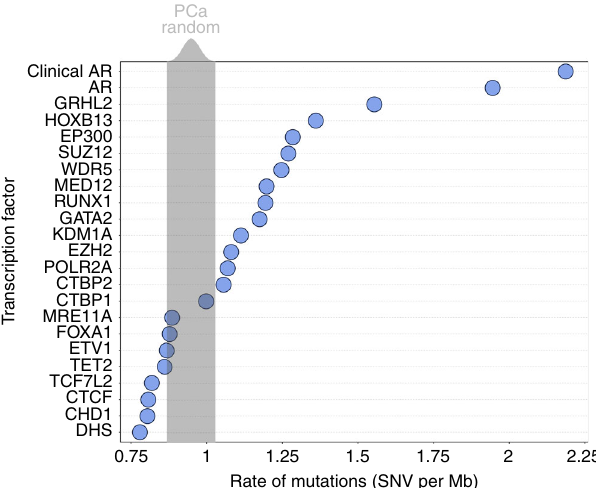
Fig. 1 ARBS sites are the most heavily mutated TF-binding sites. The rate of mutations (SNV per Mb) at individual TF-binding sites ( n = 22) and DHS regions were compared with randomized chromosomal regions (1000 iterations, gray). All TF-binding data were generated from a secondary cell line except “ Clinical AR ” that are high-con fi dence ARBS from patients PCa